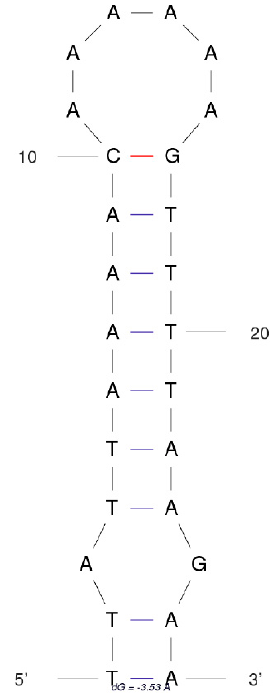
Figure 2. Stem-loop hairpin structure of origins of light-strand replication (OL)-like region in H. sinicus mitogenome.